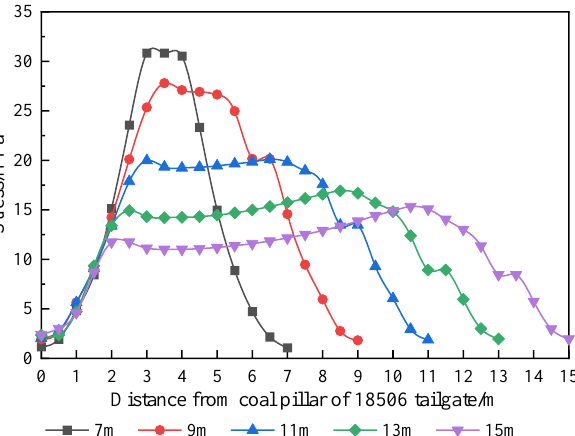
Figure 6. Vertical stress distribution curve of coal pillars with different widths during mining.